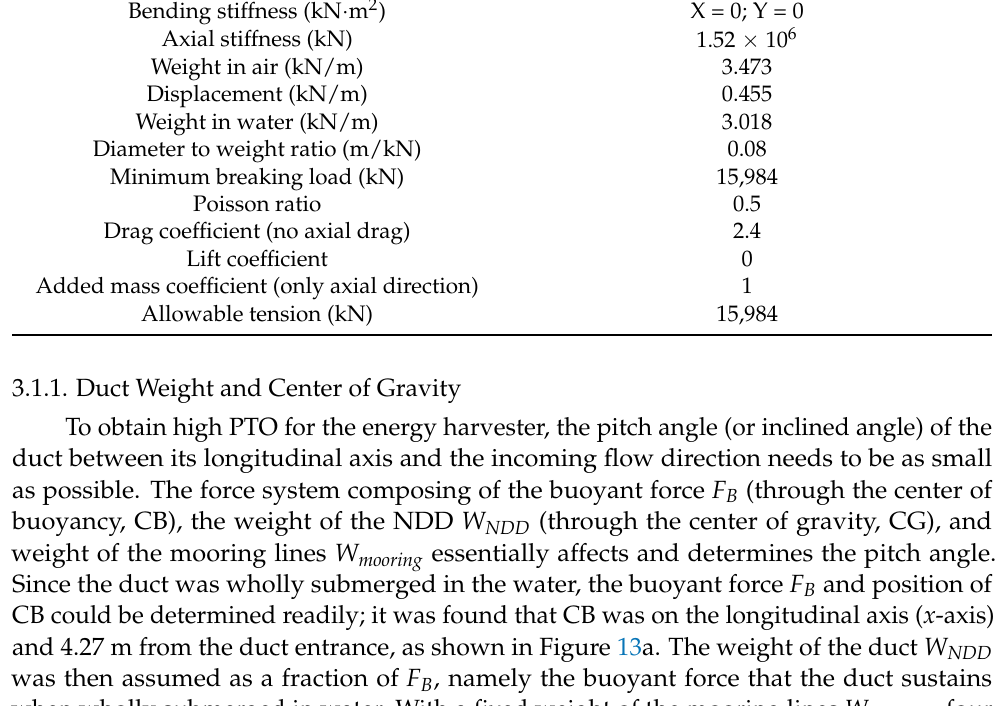
Table 3. Mooring line properties.